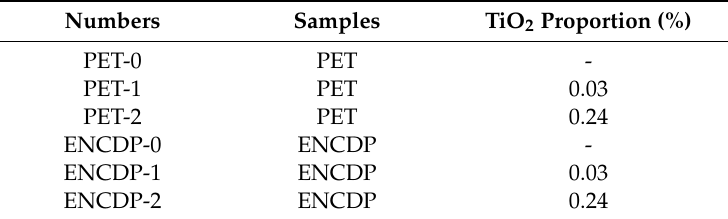
Table 1. Samples and its corresponding